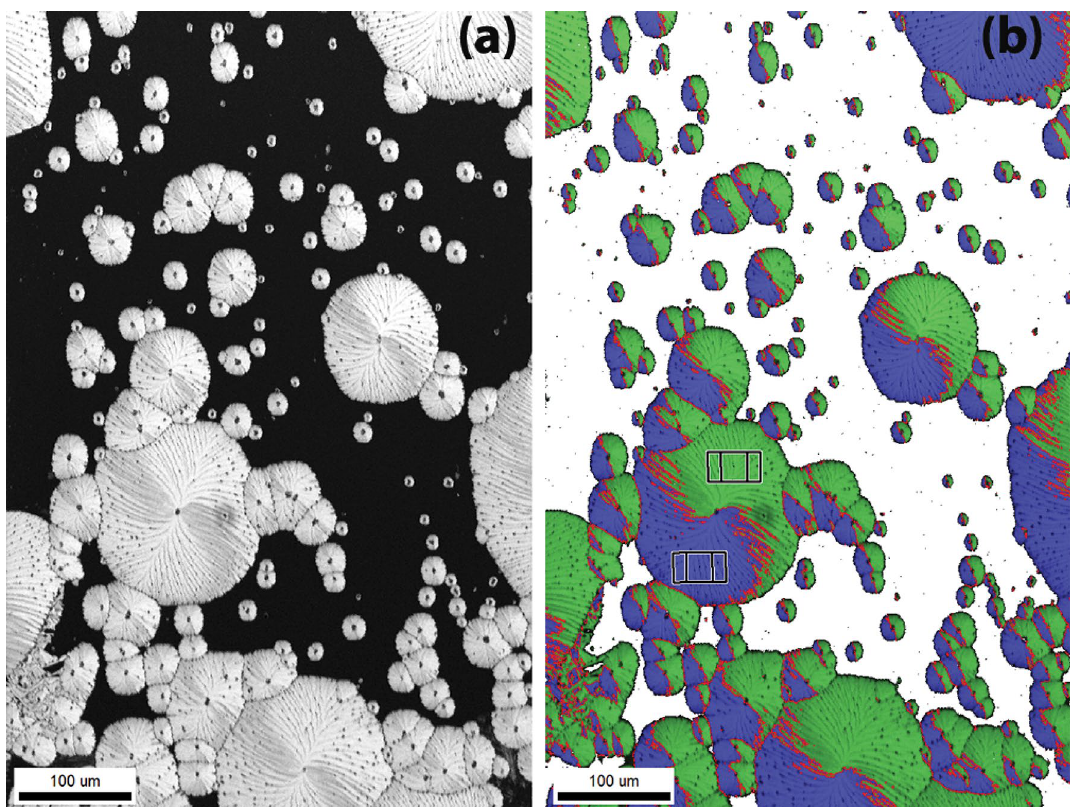
Figure 6. EBSD analysis of domains on Si 0.75 Ge 0.25 O 2 thin films. ( a ) Image Quality (IQ) map where the grey-scale represents the degree of crystallinity. ( b ) Quartz crystal orientations map showing two observed orientations: ( ¯ 1010 ) [ 0001 ] (blue) and ( ¯ 1100 ) [ 0001 ] (green), combined with the IQ signal. All quartz domains are composed of Dauphiné twins and the red lines are the twin boundaries. Notice the shape of the twin boundaries is dependent on the size of the domains: For small domains, the twin boundaries are nearly vertical lines;